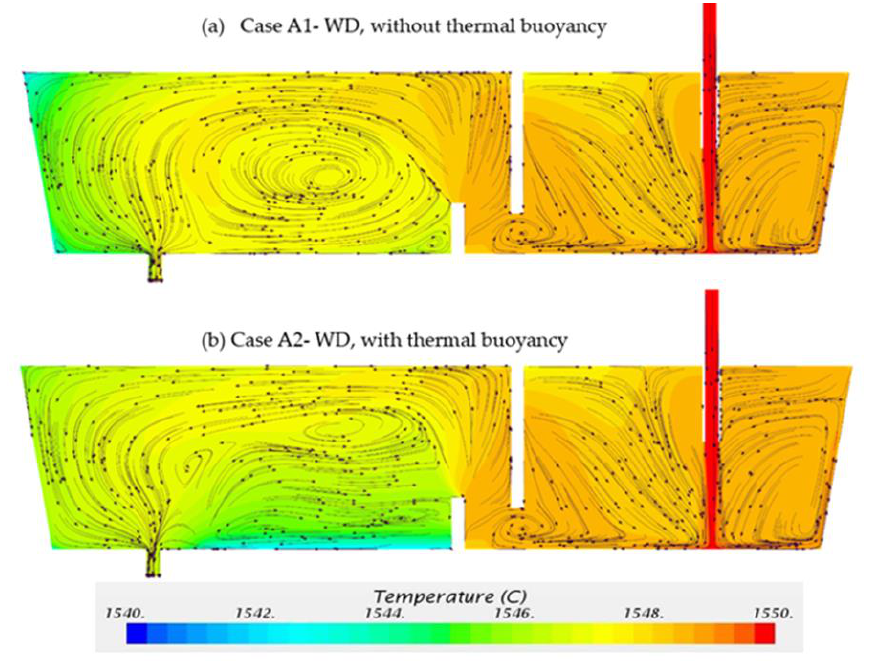
Figure 11. Temperature and flow pattern in ( a ) Case A1—without thermal buoyancy and ( b ) Case A2—with thermal buoyancy.